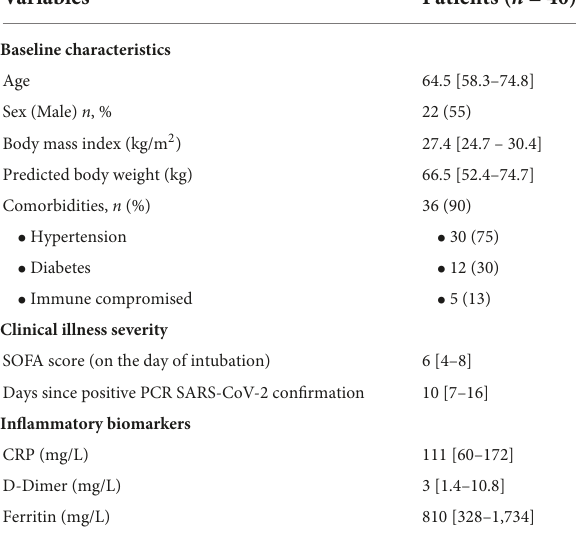
TABLE 1 Patient characteristics at